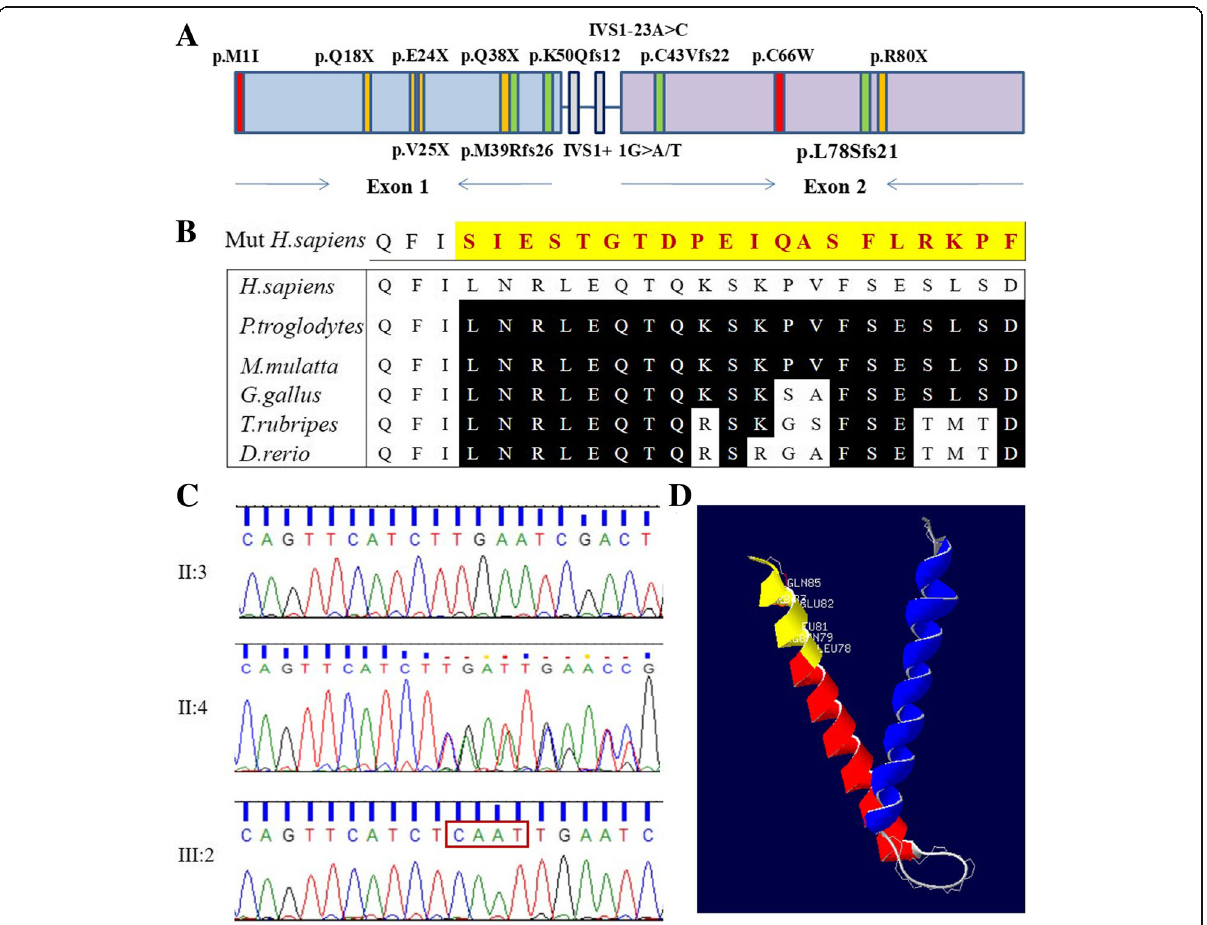
Fig. 4 Gene identification in TIMM8A of Family 1. a General structure of TIMM8A protein showing the positions of variations identified in MTS patients. Red colour presents missense variation, yellow indicates nonsense variation, and green indicates frameshift. b Wild-type and mutated amino acid sequences indicating the amino acid changes after variation p.L78Sfs21, and protein alignment showing conservation from amino acids position 78 to 97 across five species. c Sequencing chromatograms of TIMM8a showing the insertion in affected individuals (lower panel) compared with that of normal controls (upper panel). The inserted nucleotides are marked by red frames. d Three-dimensional structure of TIMM8A wild-type created by SWISS-MODEL. Mutated amino acids are coloured in